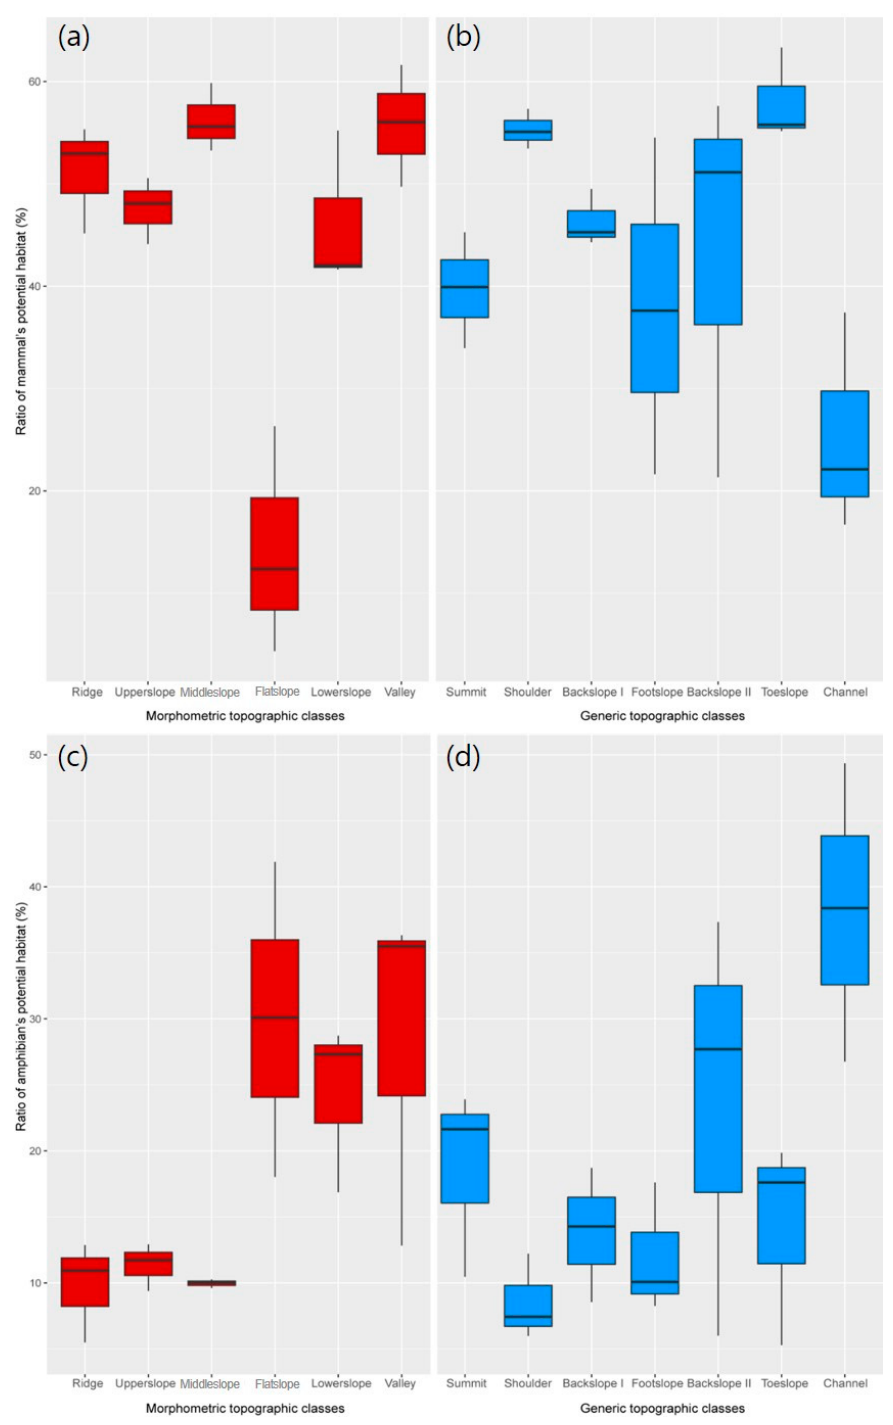
Figure 6. Ratio of the potential habitats of amphibians and mammals in the morphometric ( a , c ) and generic ( b , d ) topographic classes. The ratio of the potential habitat of mammals and amphibians in the morphometric topographic classification was quite similar to their habitat preference and movement ability. However, in the generic topographic classification, the distribution of the amphibians and mammals was not related to the erosion-accumulation process.